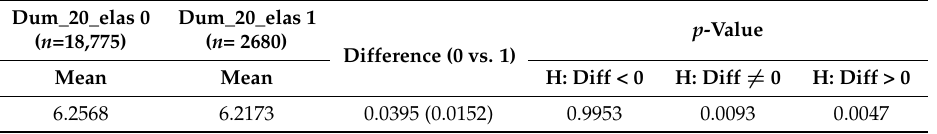
Table 5. Difference test of means in logarithm of hourly consumption by Dum_20_elas variable. Dum_20_elas 0 ( n =18,775)